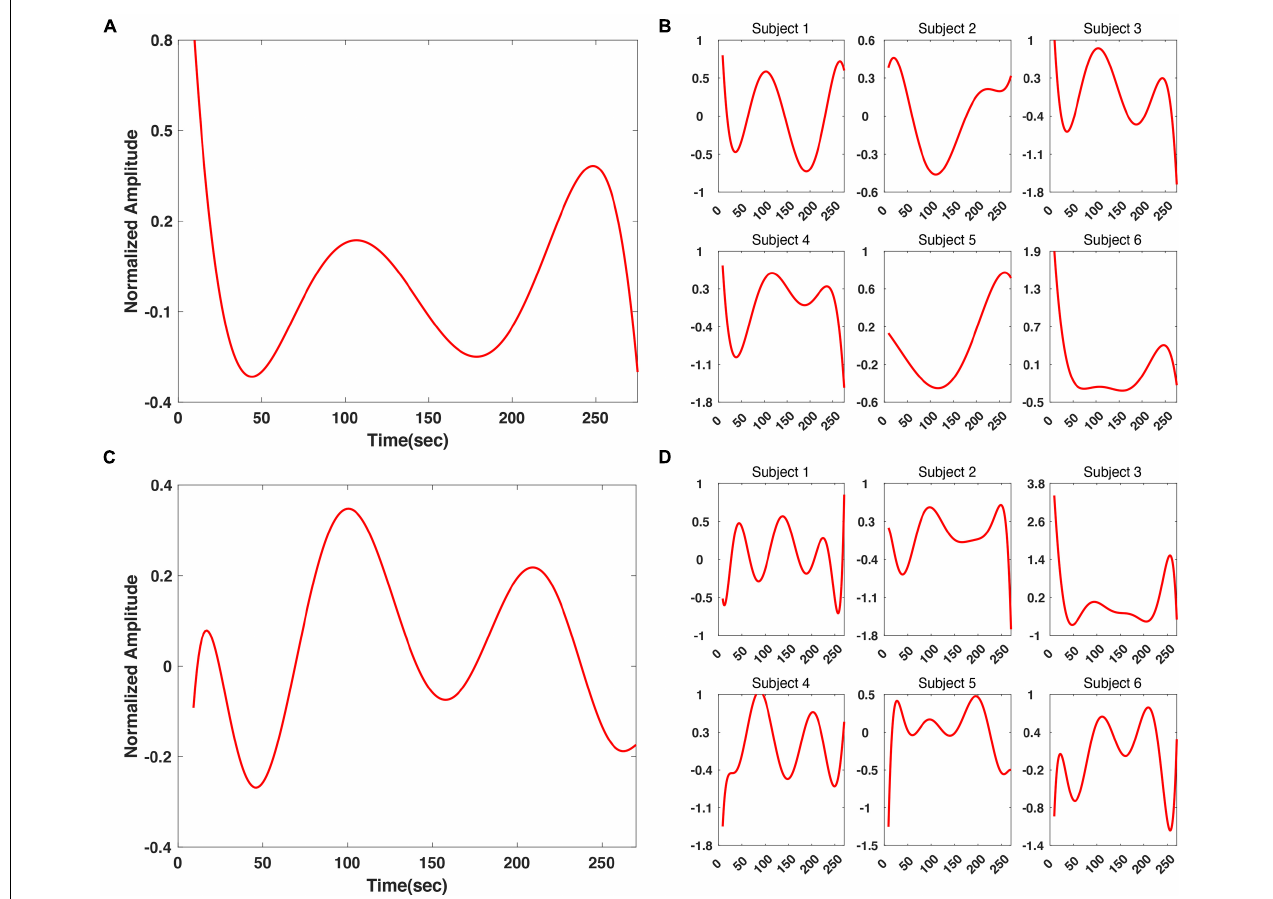
FIGURE 7 | Comparison between grand averaged and individual polynomial regression results of SSVEP response at 6 Hz. (A) Grand averaged polynomial regression result for “fear” video. (B) Individual polynomial regression result for “fear” video. (C) Grand averaged polynomial regression result for “nervous” video. (D) Individual polynomial regression result for “nervous”